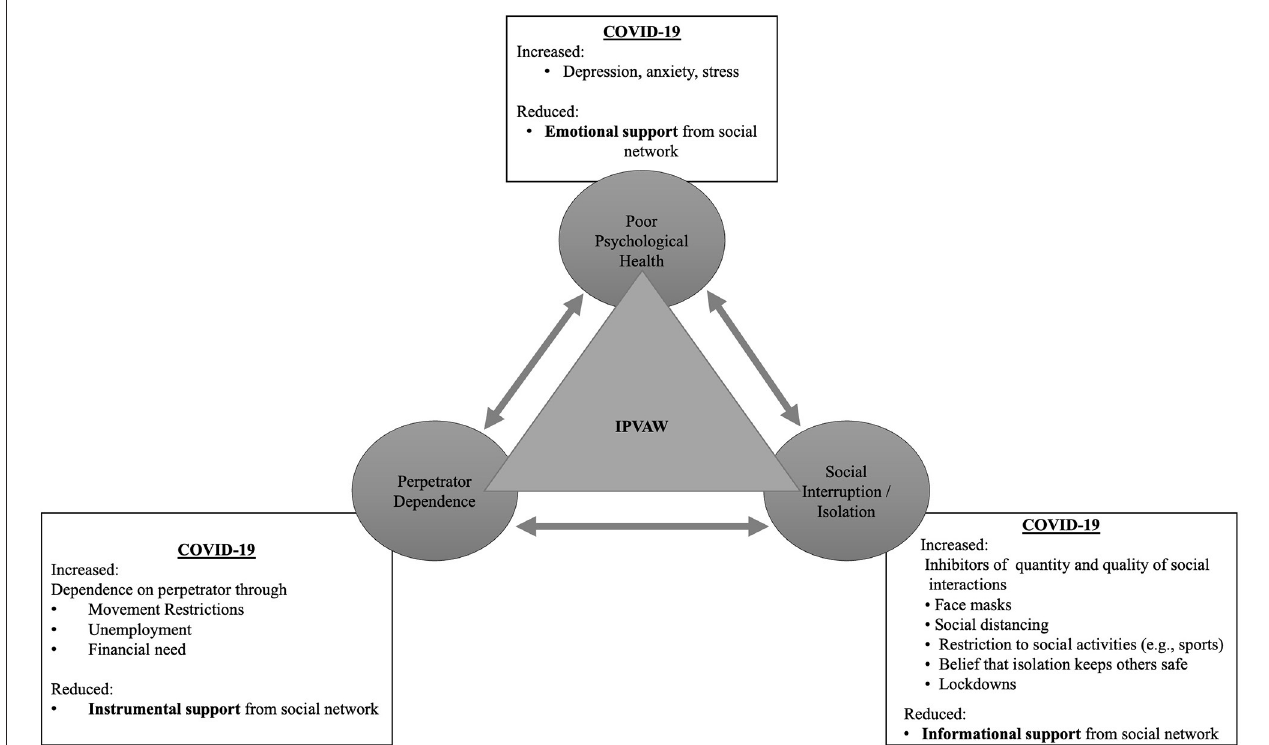
FIGURE 1 | COVID-19 social restriction as additional stressors to IPV risk factors.